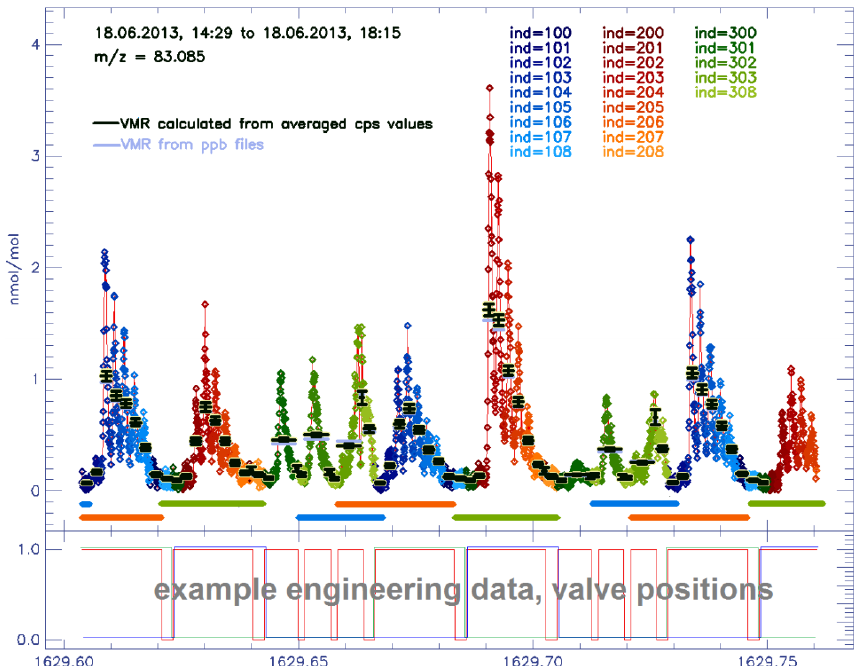
Figure 7. Mixing ratios detected at m/z 83 . 085 over 4h period during the SOAS campaign in summer 2013. See text body for more details. The data have been categorized using the index parameters depicted in Fig. B3. The PTR-TOF-MS was connected to three inlets: aerosol sampler A (blue index values, 100–108), aerosol sampler B (red index values, 200–208), and a thermal desorption three-stage denuder inlet (green index values, 300–308) to sample semivolatile compounds in the gas phase. The sampling times for aerosol inlets A (blue), B (red), and the three-stage denuder (green) are indicated as horizontal lines below the zero line. The lower lines indicate sampling of background (i.e., particle free ambient air for the aerosol inlets and zero air for the gas phase inlet), and the upper lines indicate sampling of ambient air. The lower chart shows engineering data that show the status of different valves (i.e., 0 closed, 1 open) in the setup. The blue line, for example, is 1 when aerosol inlet B is analyzed. This data set can thus be used to label data associated with aerosol inlet